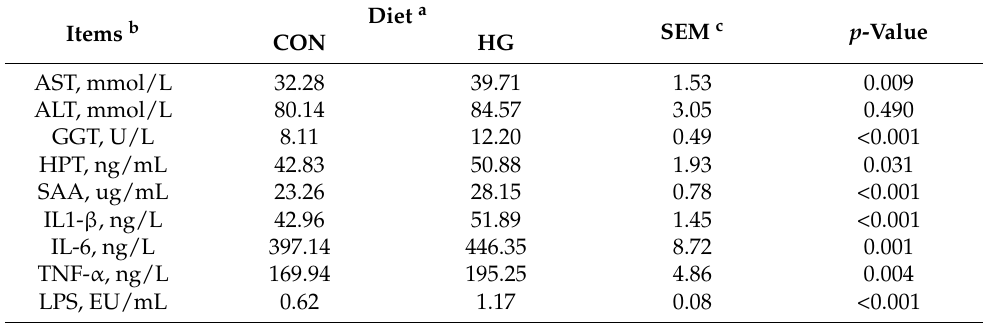
Table 2. Effects of high-grain diet on the blood metabolites of yaks.